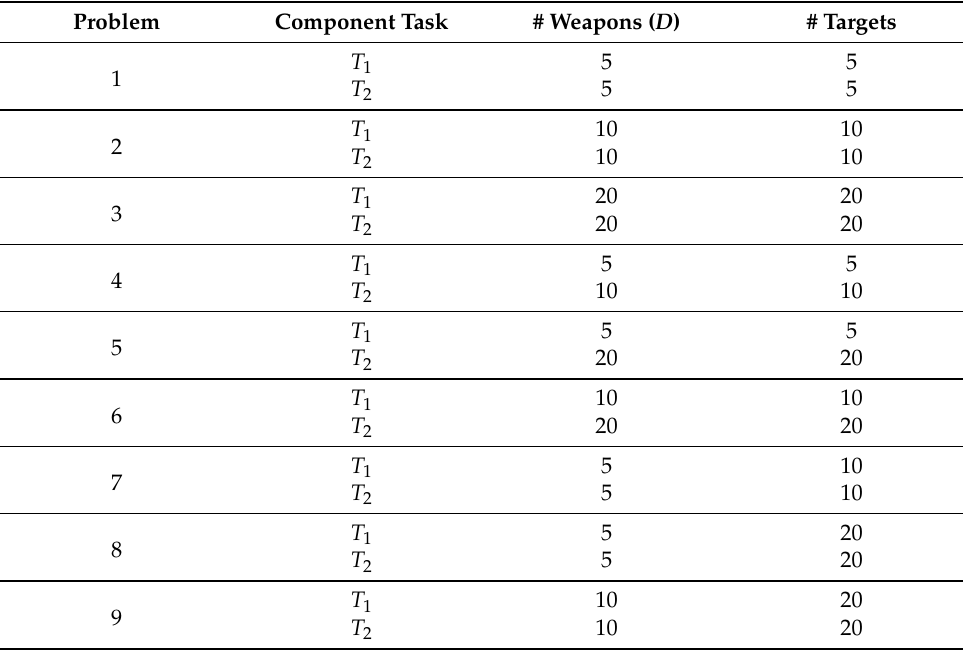
Table 2. Details of the 9 MTO problems regarding the WTA in test suite